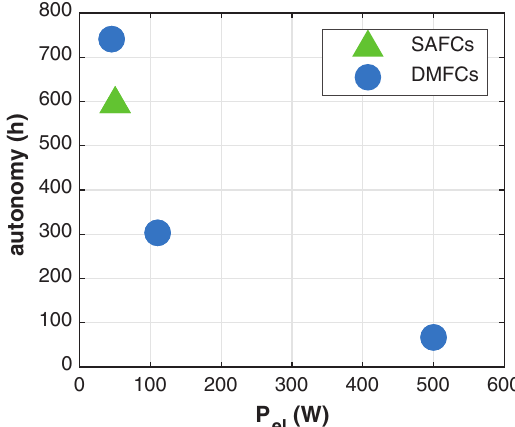
Figure 5. Hours of continuous operations of methanol-fueled fuel cells when using a 30 L capac- ity